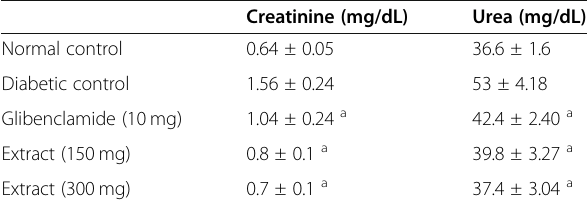
Table 7 Consequences of rhizomes of Sorghum halepense (L.) Pers extract on serum level of serum creatinine and urea